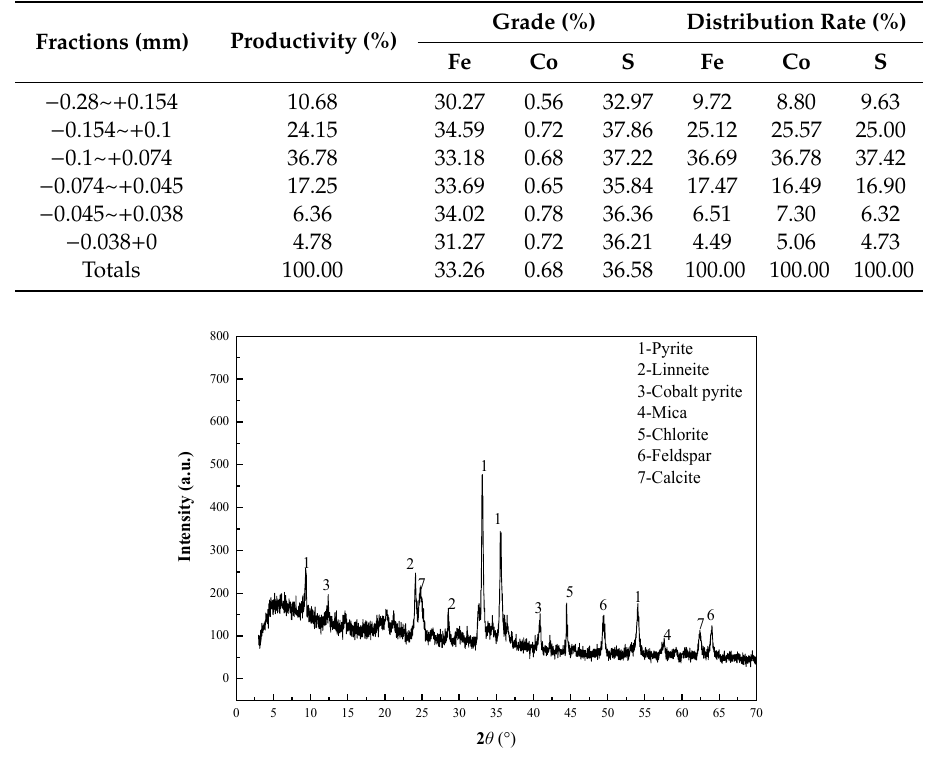
Figure 1. X-ray di ff raction (XRD) di ff ractogram of Co-bearing sulfur concentrate. Figure 1. X-ray diffraction (XRD) diffractogram of Co-bearing sulfur concentrate.